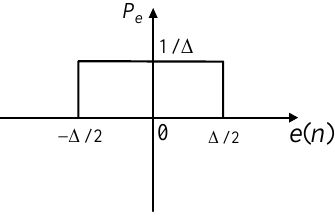
Figure 8 . Probability density function. Figure 8. Probability density